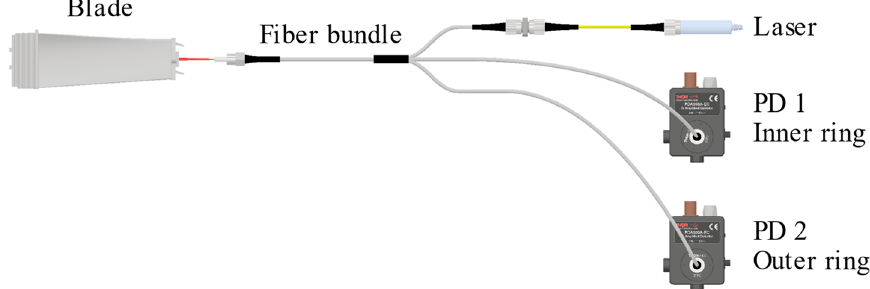
Figure 2. Schematic representation of the light-to-voltage conversion for OS 2 and OS 3. PD stands for photodetector. PD 1 and PD 2 are connected to inner and outer rings, respectively.